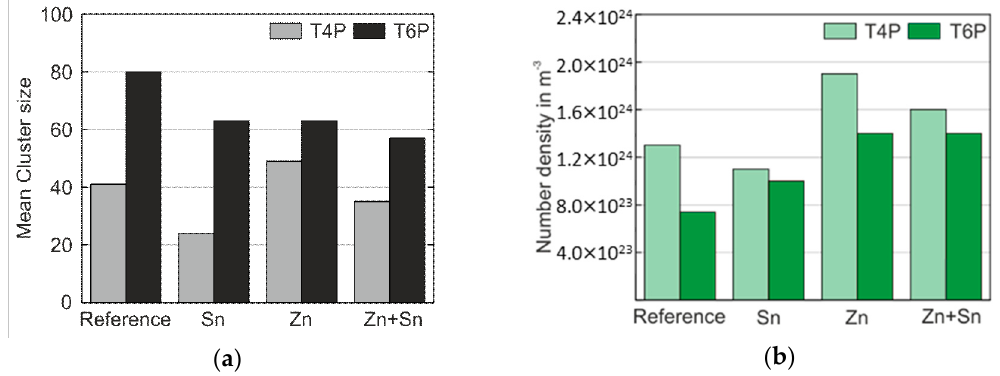
Figure 7 . ( a ) Mean cluster size of the Mg–Si co-clusters in the T4P and T6P conditions; ( b ) the corresponding number density, N.